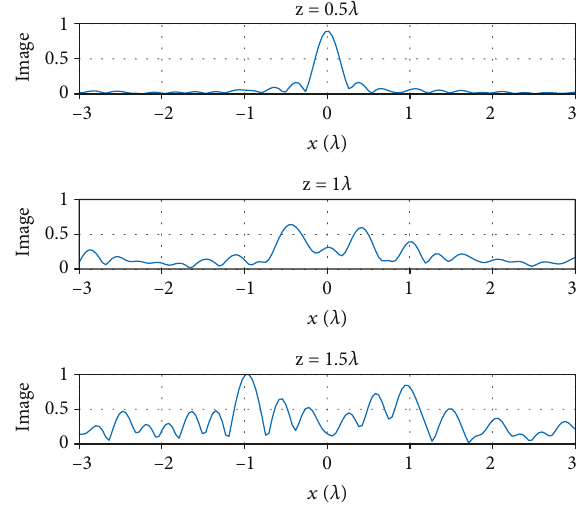
Figure 14: Reconstructed images when using 13 resonant dipole antennas. For this example, the parameters are z z =1.5 λ , d = λ , d =2 λ , s = λ /8, and D =0.25 λ . These results are 3 2 3 with SNR =10dB.